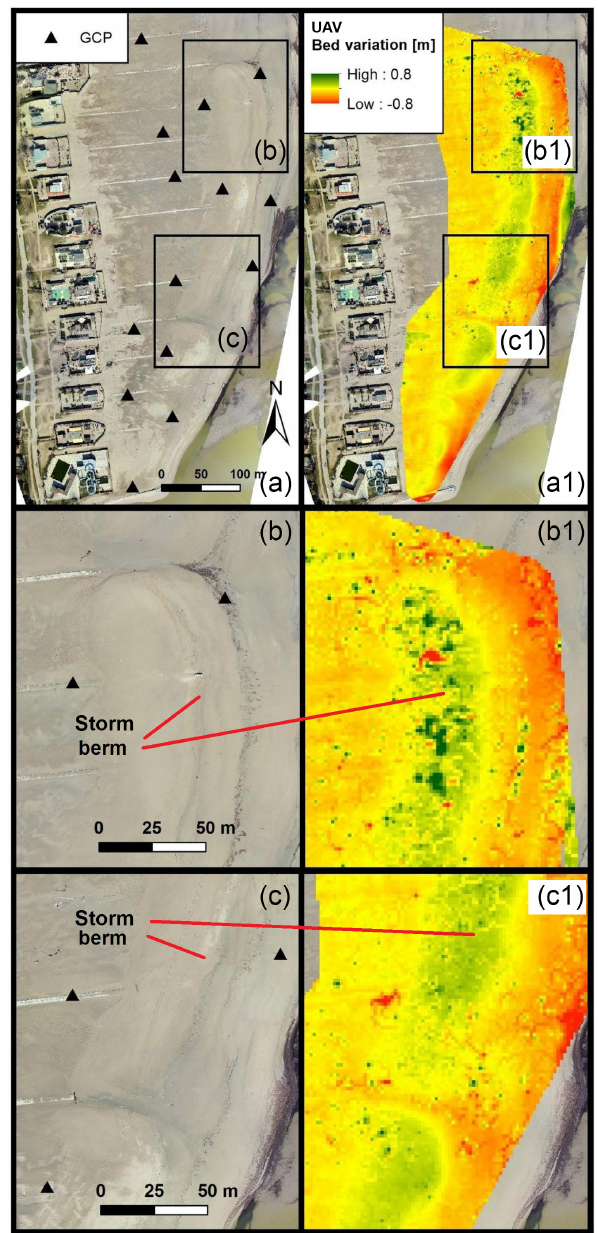
Figure 7. Morphological variations: (a) the UAV-derived orthomo- saic of the target area, where morphological features are visible along with the position of the GCPs; (a1) the difference between the post-event UAV-derived DSM and the pre-storm lidar-derived DTM. In (b, b1) and (c, c1) enlargements of the main features are given. The morphological variations are only shown for the area surrounded by the